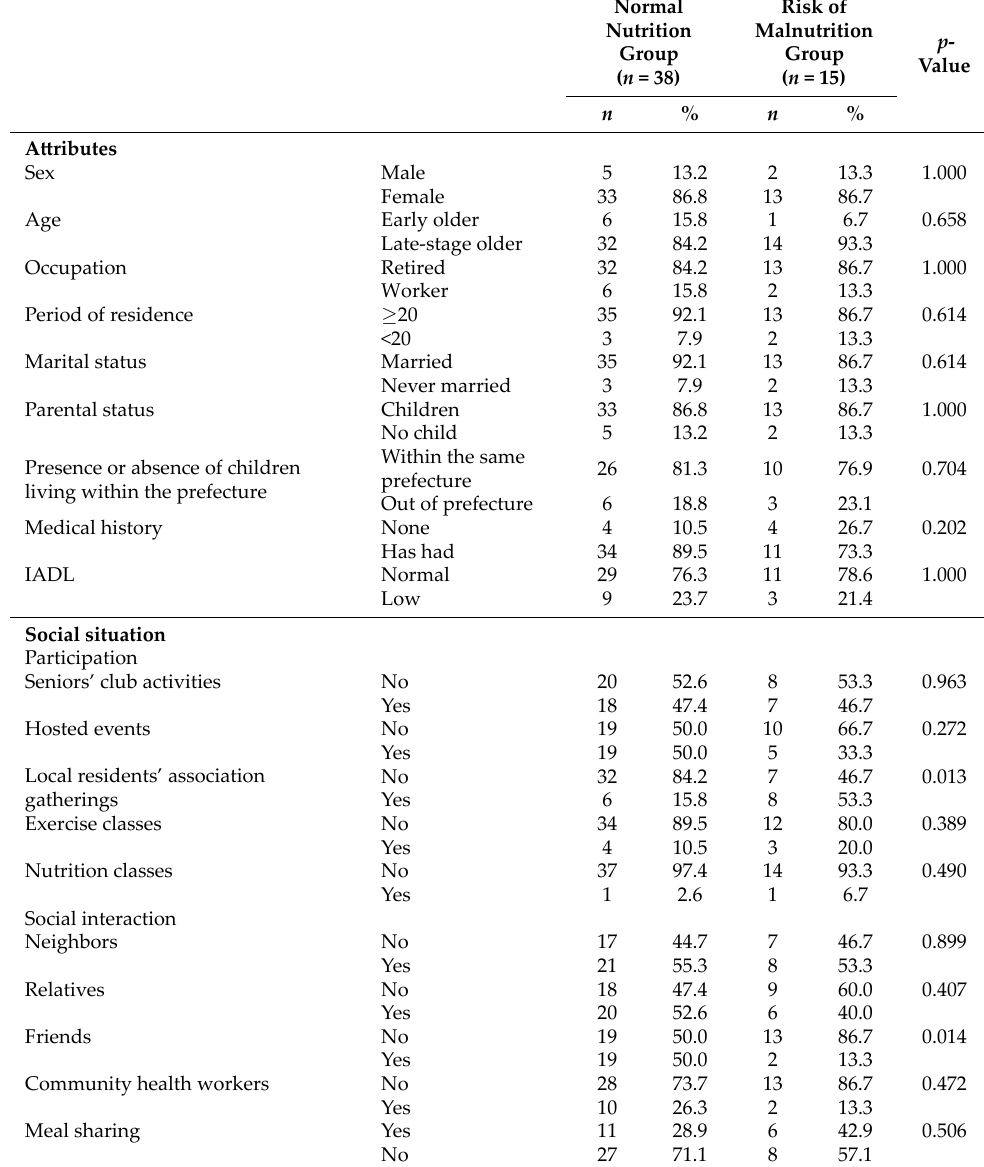
Table 3. Relationship between social situation, psychological state, and MNA‑SF categories ( n =